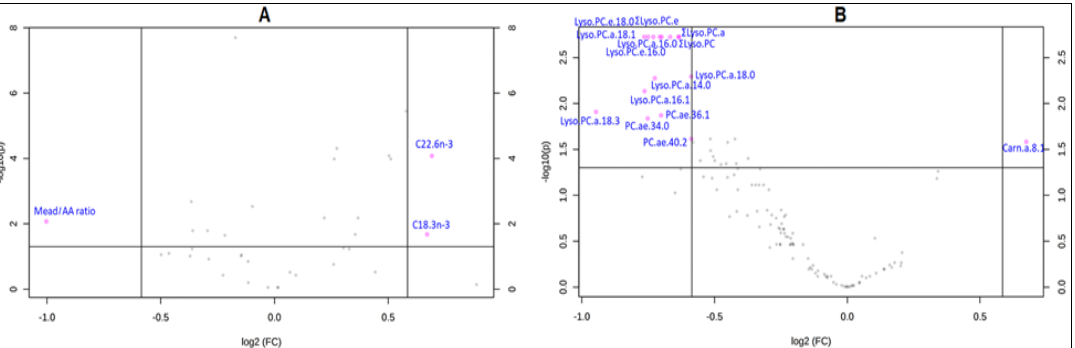
Figure 1. Volcano plot depicting metabolites with significant changes during intervention: ( A ) total glycerophospholipid fatty acids ( B ) phospholipid species with fold change (FC) threshold of 1.5 and t-tests threshold of 0.05. The log transformed fold changes and the p -values are represented on x- and y -axis, respectively. The red circles represent features above the selected thresholds. Metabolites lying further away from the (0,0) are more